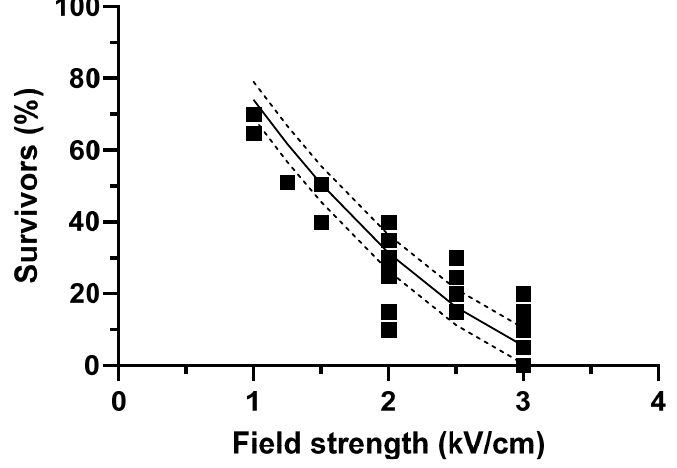
Figure 4. Survivability of Anisakis L3 larvae after applying 30 µs pulses of 50 kJ/kg at different field strengths (square points) to pieces of hake meat, compared with the survivability estimated (continued lines) by the equation obtained in saline solution shown in Table 2 (the dotted lines correspond to the 95% confidence intervals).